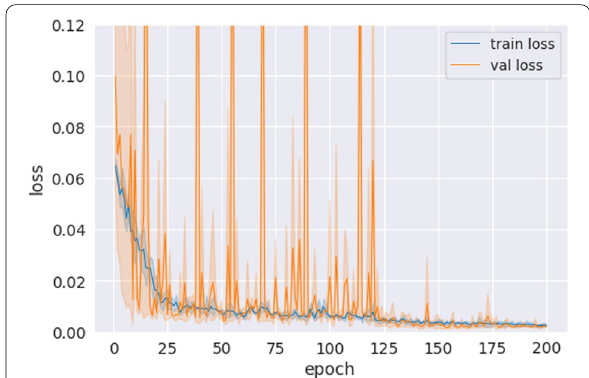
Fig. 6 Characteristic training curves of the deep quality prediction network. The plot is an aggregate of all the different validation folds. The validation loss often spikes in early training, which then disappear safter the learning rate reduction at 120 epochs